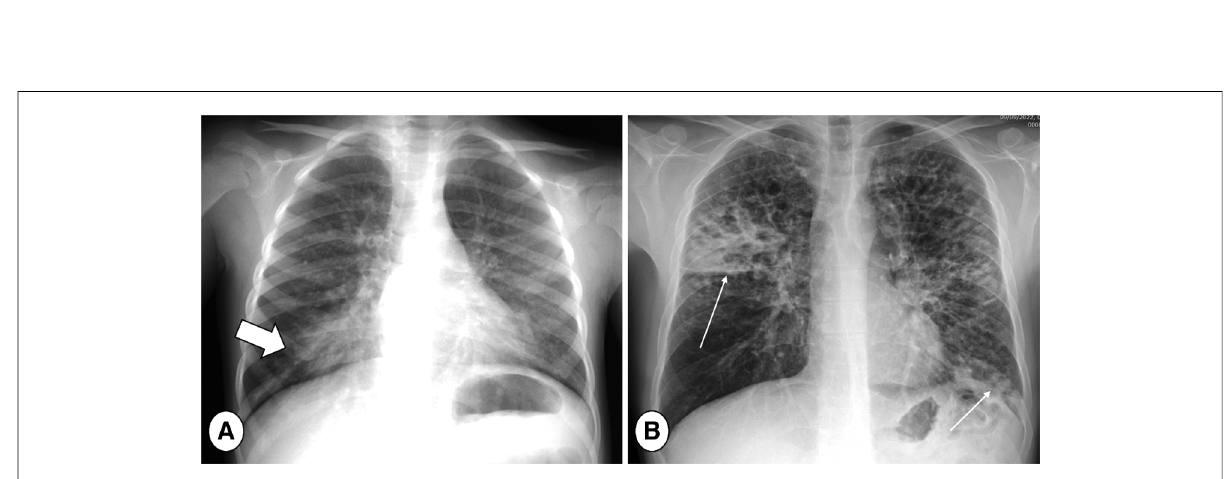
FIGURE 3 Posterior-Anterior (PA) chest radiograph in mild ( A ) and severe ( B ) cystic fi brosis lung disease during respiratory tract exacerbation. Note large consolidation in the right lung base in image A indicating respiratory tract exacerbation (thick arrow) and bilateral consolidations in the right upper lobe and left lung base (B, thin